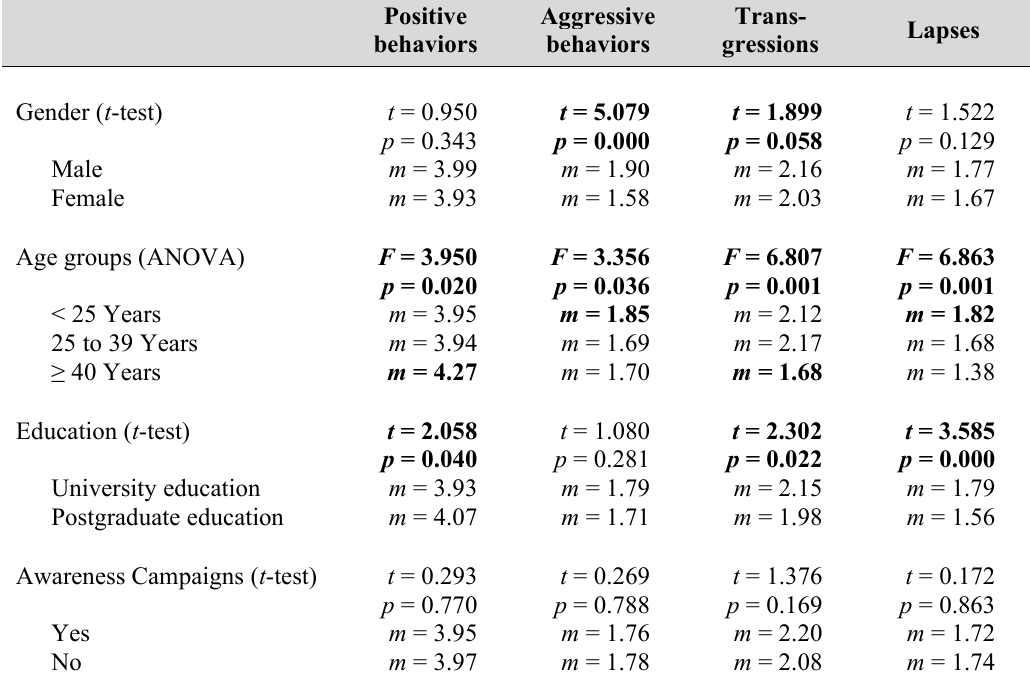
Table 4 ANOVA and t -test results